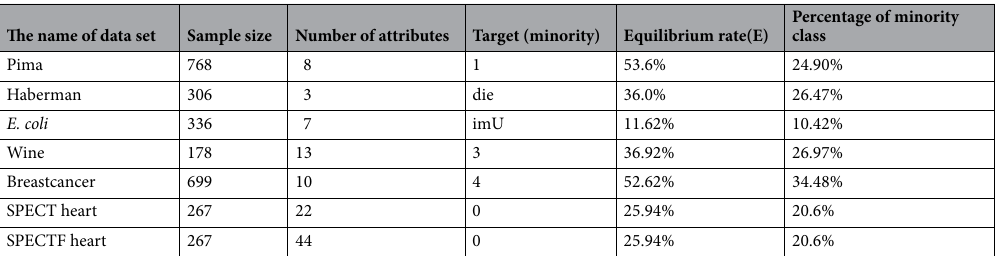
Table 2. The description of the data sets.